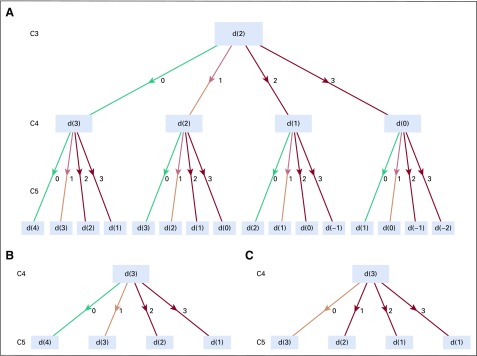
Dose transition pathways (DTP) flow diagrams. Flow diagrams presenting the different pathways for dose (d) recommendations on the basis of the possible patient outcome permutations within the trial for future cohorts (C). (A) DTP for C3 to C5 on the basis of no observed DLTs for C1 and C2: (zero of three at dose 0 and zero of three at dose 1). The recommended dose for C3 is dose 2. The DTP for subsequent cohorts only apply if the cohort size is three at the recommended dose. (B, C) Two scenarios where this is not the case. (B) Scenario in which C3 consist of two patients who received dose level 2 and one patient received dose level 3, with no dose-limiting toxicities (DLTs) experienced. (C) Scenario in which C3 consist of two patients who received dose level 2 and one patient received dose level 3, with no DLT at dose level 2 but a DLT experienced by the patient who received dose level 3.